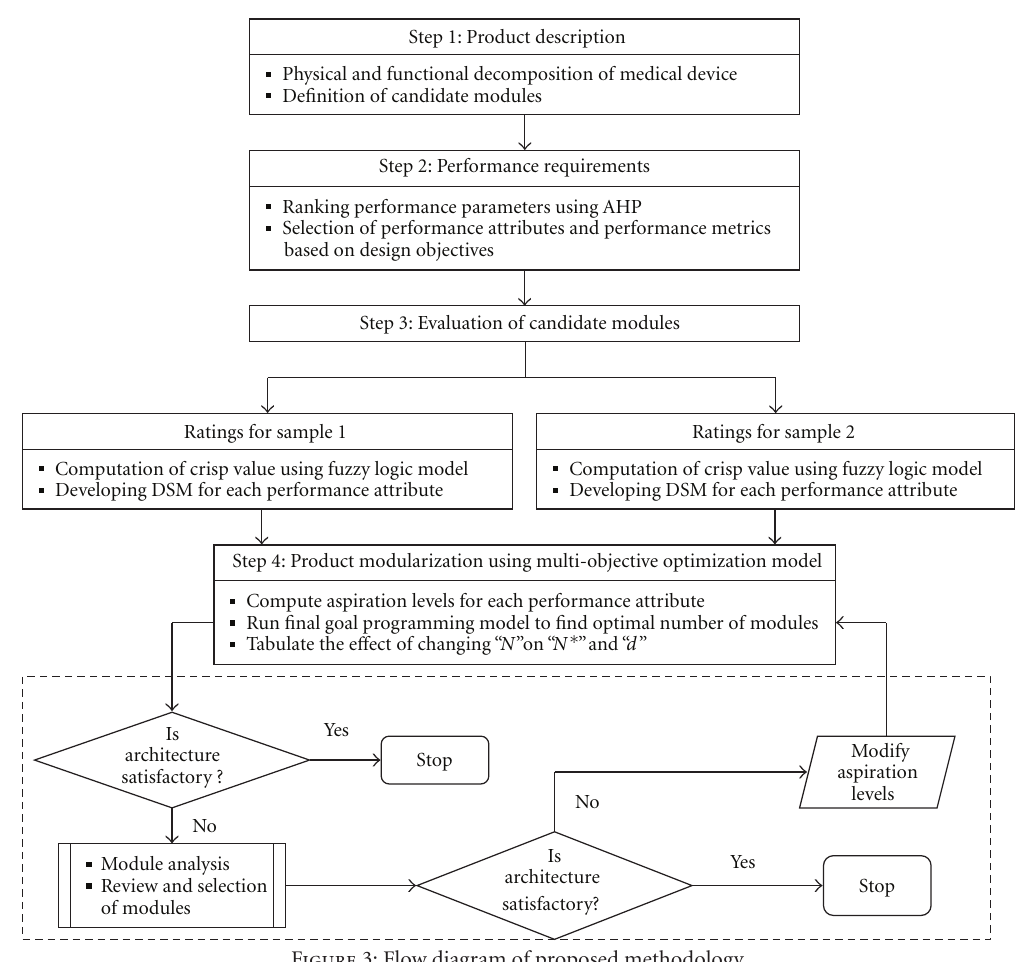
Figure 3: Flow diagram of proposed